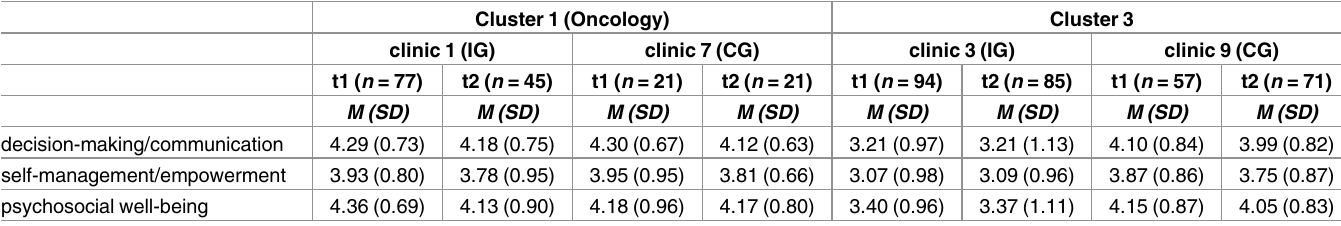
Table 8. Clinic specific means of outcome criteria of the patient survey (Cluster 1 and